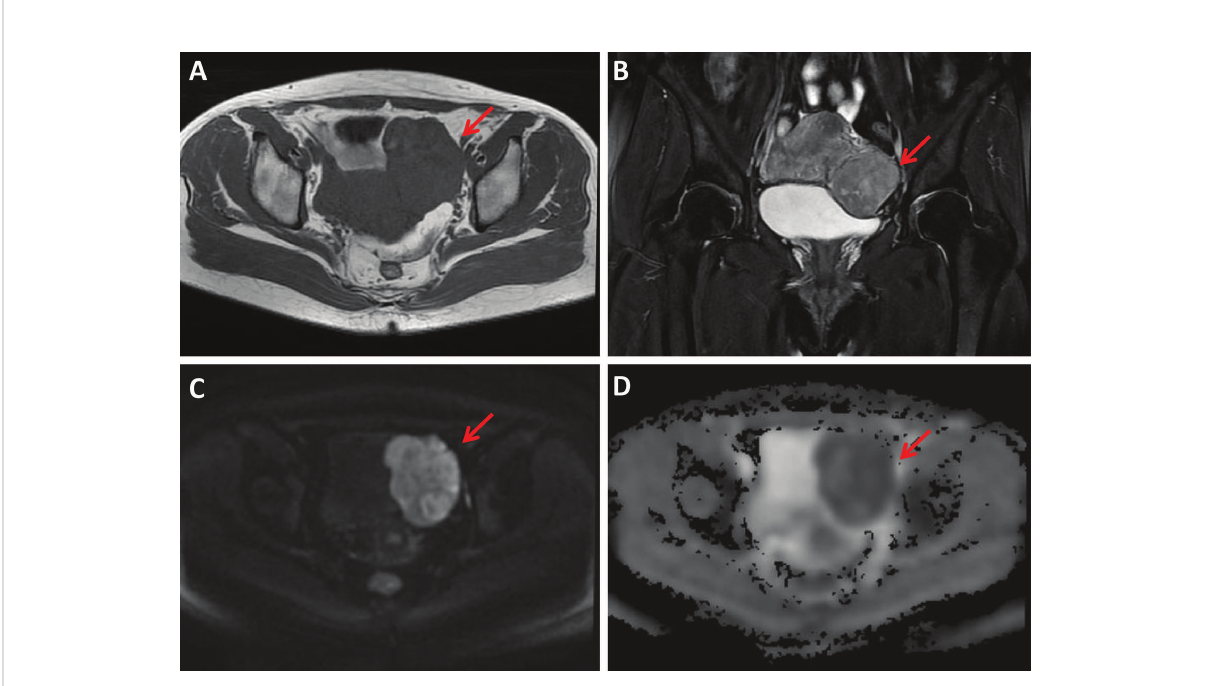
FIGURE 3 A 49-year-old woman with a uterine sarcoma. A mass was found in the uterine-side wall (arrow) with an unclear margin, showing heterogeneous iso-to-hyperintensity on T1WI (A) and heterogeneous hyperintensity on T2WI images (B) . The tumor showed high signal intensity on diffusion-weighted MR image (C) with a low ADC value (ADC = 736 × 10 -6 mm 2 /sec) (D) .